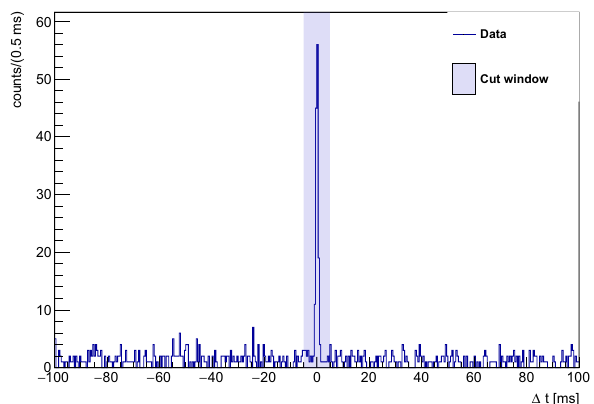
Fig. 7 Time differences between muon veto and LMO detector events after we have subtracted off the peak offset ( ∼ 60 ms). The cut of ± 5 ms is used in our analysis. To obtain a good signal-to-noise ratio, only events with M > 1 in the LMO detectors are